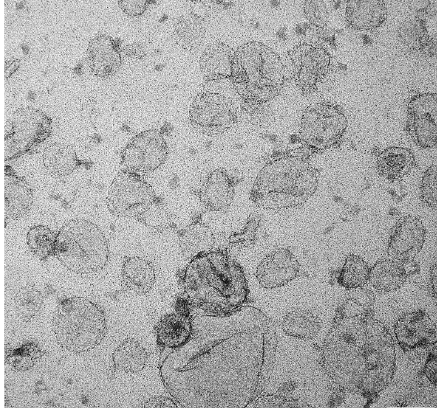
Figure 3. Air-dried exosomes prepared from G361 melanoma cells cultured in exosome-depleted calf serum. Exosomes were adsorbed on a formvar membrane, fixed with 1% glutaraldehyde and contrasted by uranyl acetate, and detected using an electron microscope. The bar is 50 nm.